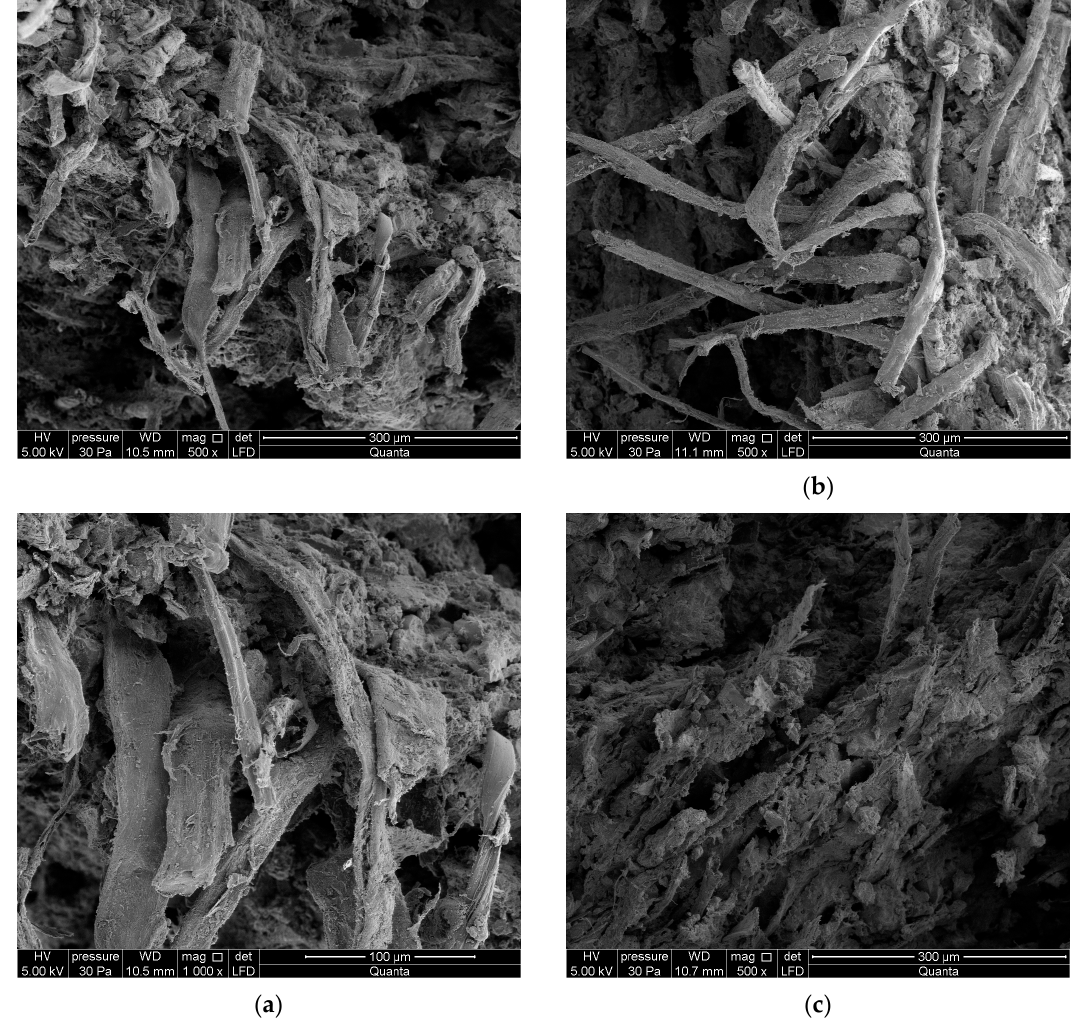
Figure 13. SEM images of boards: ( a ) series B R (magnification 1000 × at top, 500 × at bottom), ( b ) series B 1 , ( c ) series B 10 .